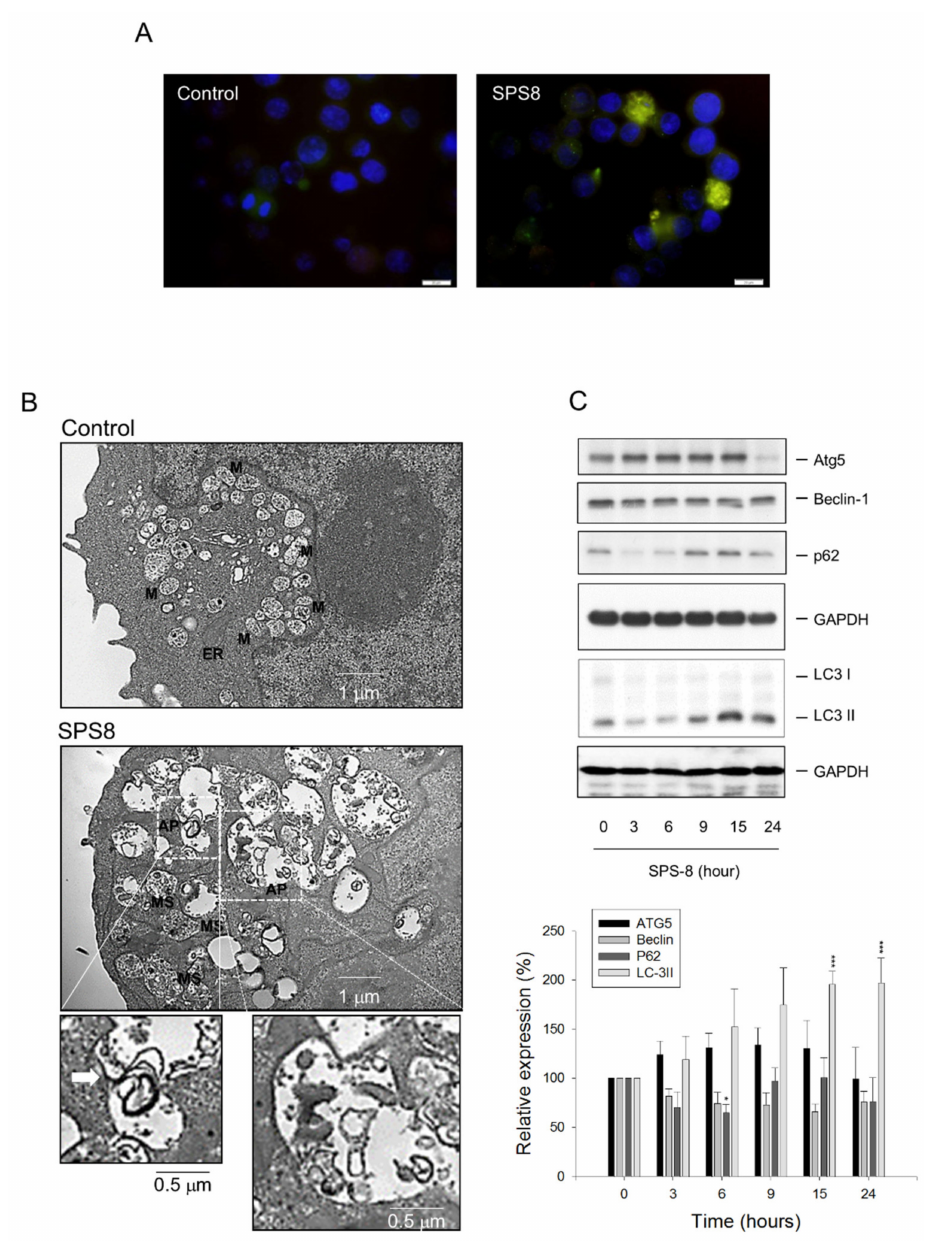
Figure 3. E ff ect of SPS8 on the induction of autophagy. HL-60 cells were incubated in the absence or presence of SPS8 (5 µ M) for 24 h ( A , B ) or the indicated times ( C ). ( A ) The immunofluorescence staining for LC3 (green) and DAPI (blue) was performed. Scale bar, 20 µ m. ( B ) A TEM analysis of organelle morphology was performed. The endoplasmic reticulum (ER), mitochondria (M), and swelling mitochondria (SM) were observed. The formation of autophagosome (AP)-like structures containing double membranes and engulfed organelle debris was also detected. ( C ) The cells were harvested for the detection of protein expression, using Western blotting. Several autophagy-related protein expressions were examined. The expressions were quantified using Image Lab Software 6.0 (BIO-RAD). Data are expressed as the mean ± SEM of four to six independent experiments. * p < 0.05 and *** p < 0.001 compared with the zero time